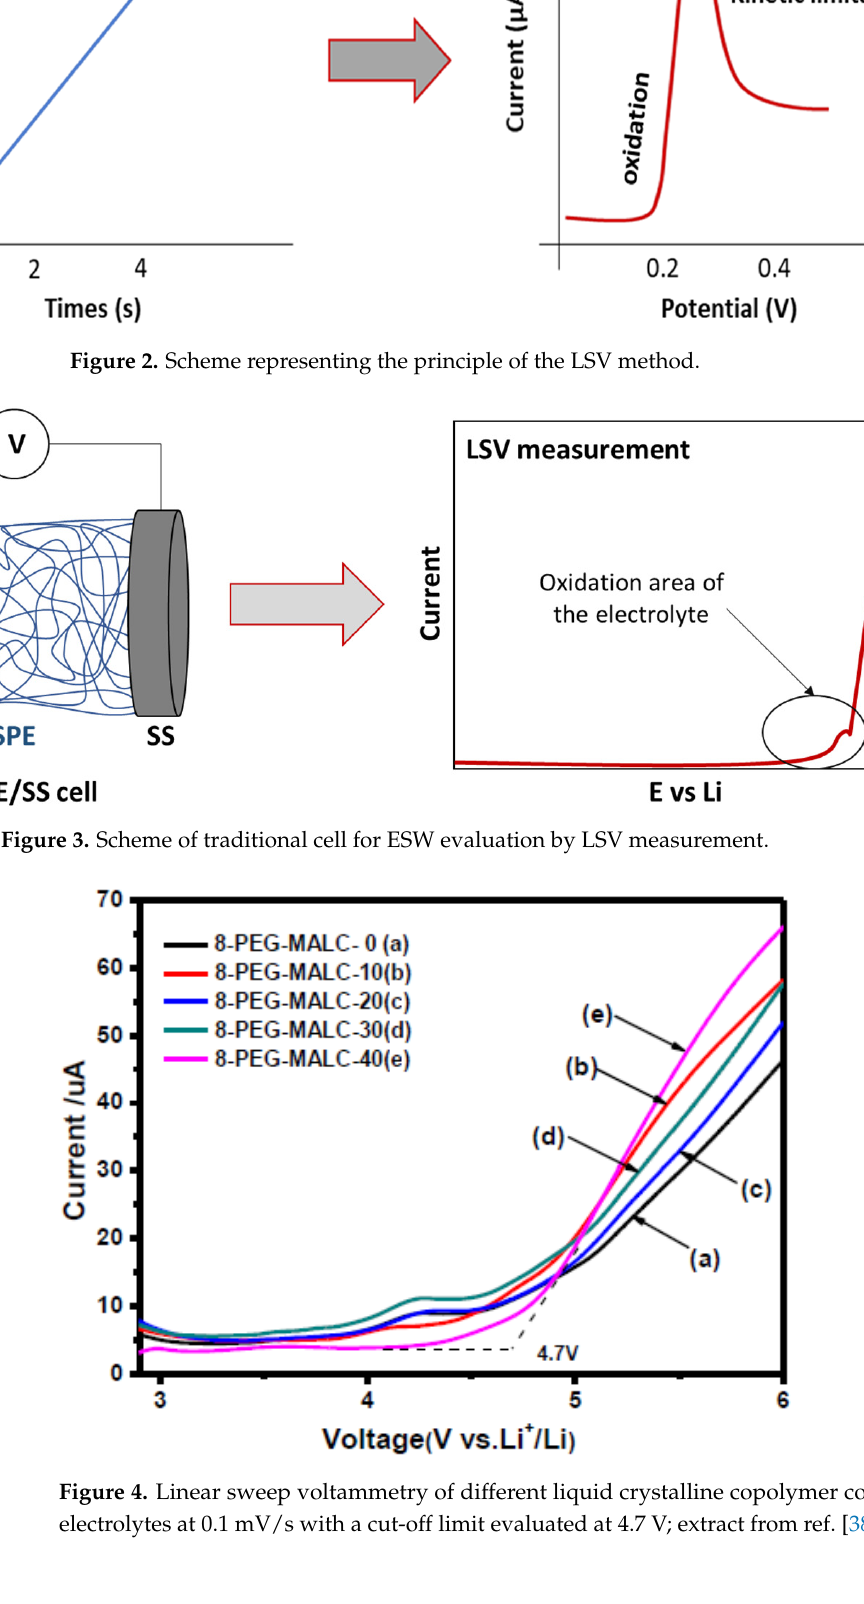
is reached, the working electrode’s potential is ramped back in the opposite direction to the initial potential. These cycles of potential sweeps can be repeated as many times as needed (Figure 5b,c). However, it is important to keep in mind that once the first oxidation is initiated, it is likely that during the other cycles the material has been altered due to this first oxidation. The current at the working electrode is plotted versus the applied voltage to give the cyclic voltammogram. Oxidation (positive current) and reduction (negative current) peaks can be observed if redox species react at the surface of the working elec- trode. These reactions can be related to the stability of the species. Especially, when ana- lyzing electrolyte solutions and naturally for solid electrolytes such as SPEs or SCEs, the appearance of intense redox peaks at a given potential is characteristic of the occurrence of a reaction which can be related to electrolyte degradation. It is important to note that two different cells must be used for the evaluation of the anodic and the cathodic stability of the electrolyte even if some authors still use the same cell for both analyses. For instance, in their work, Piana et al. [62] made the choice to evaluate the SCE (PEO/LAGP hybrid electrolyte) by scanning the cell potential from the OCV (open circuit potential) down to- ward − 0.3 vs. Li + /Li and, then, upward to 2.5 V vs. Li + /Li (cathodic stability window) in a Li/SCE/Cu cell configuration, and from the OCV toward 5.0 V vs. Li + /Li and, then, down- ward to 2.5 V vs. Li + /Li (anodic stability window) in a Li/SCE/Carbon black cell configu- ration with a scanning rate of 0.1 mV/s. In that case, both cells use planar working elec- trodes (Cu and carbon black coated Al foil) for the ESW evaluation. Thus, the stability of the SPEs and SCEs can be analyzed via CV in a similar way to with LSV. The cell config- uration is often identical to the one for LSV analysis and, once again, a huge range of choices about the setup of parameters like temperature and scanning rates is also ob- served. For instance, Figure 6 shows the distribution of scanning rates used for ESW eval- uation by LSV/CV taken from Table 1. A clear trend towards low and moderate scanning rates (0.1 to 1 mV/s) is observed. However, many other authors use higher scanning rates (>5 mV/s). It must also be noted that even 1 mV/s can be considered to be a high scanning rate for ESW evaluations because of the sluggish processes involved in the degradation of solid-state electrolytes.